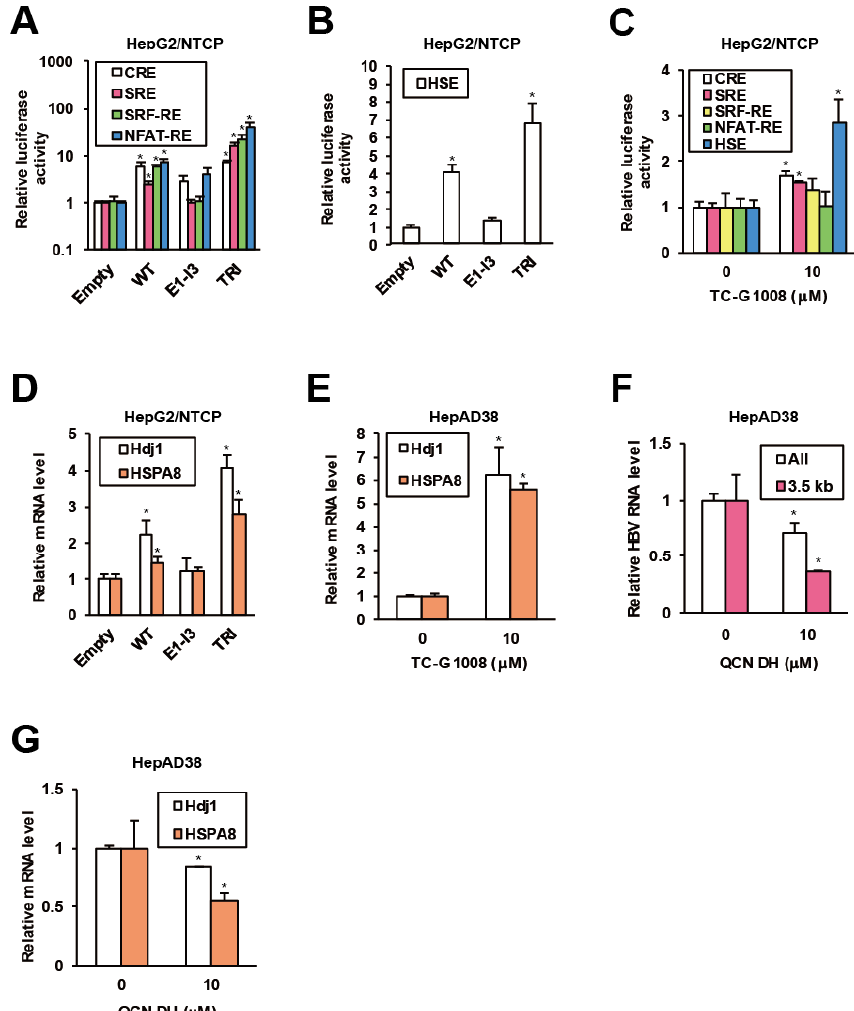
Figure 3. GPR39 facilitates HSR and HSP expression. ( A ) The e ff ects of GPR39 on intracellular signaling. HepG2 / NTCP cells were cotransfected with reporter plasmids for CRE, SRE, SRF-RE and NFAT-RE and expression plasmids for GPR39 proteins for 2 days, followed by the measurement of relative luciferase activities. ( B ) The e ff ects of GPR39 on HSE. HepG2 / NTCP cells were transfected with the HSE reporter and the GPR39 expression plasmids for 2 days, followed by the measurement of relative luciferase activities. ( C ) The e ff ects of TC-G 1008 on HSE. Twenty four hours after the transfection of the reporter plasmids HepG2 / NTCP cells were treated with TC-G 1008 at 10 µ M for 24 h, followed by the measurement of relative luciferase activities. ( D ) The e ff ects of lentivirally overexpressed GPR39 proteins on Hdj1 and HSPA8 in HepG2 / NTCP cells. The cells were transduced with the lentiviruses for 2 days and the relative mRNA levels were measured by qRT-PCR. ( E ) The e ff ects of TC-G 1008 on the expression of Hdj1 and HSPA8 in HepAD38 cells. After the treatment with TC-G 1008 at 10 µ M for 6 days in the presence of Tet following preculture without Tet for 7 days, the relative mRNA levels were measured by qRT-PCR. ( F ) The e ff ects of QCN on HBV RNA levels. After preculture without Tet for 7 days, HepAD38 cells were treated with QCN DH at 10 µ M for 6 days in the presence of Tet. The relative RNA levels were measured by qRT-PCR. ( G ) The e ff ects of QCN on the expression of Hdj1 and HSPA8. HepAD38 cells were treated as in ( F ) and the relative mRNA levels were measured by qRT-PCR. Statistical significances with p < 0.05 to controls were indicated by